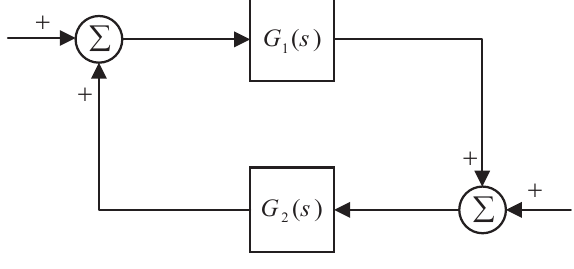
Figure 3. A simplified feedback